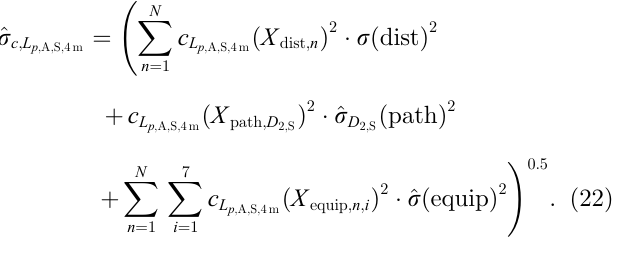
Figure 1. Boxplot representation of all 44 measurement path results for D 2,S . The individual measurement results are indicated as circles, the mean value is represented by x .